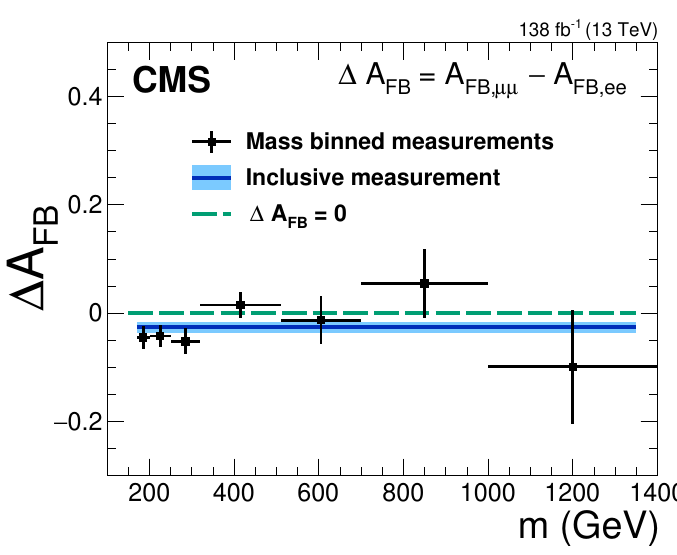
Figure 5 . Measurement of the difference in forward-backward asymmetry between the dimuon and dielectron channels. The green line is drawn at zero, the predicted value for ∆ A lepton flavor universality. The black points and error bars represent the measurements of ∆ A different mass bins. The blue line and shaded light blue region represent the inclusive measurement of ∆ A and corresponding uncertainty. The error bars on the measurements and the shaded region FB include both statistical and systematic